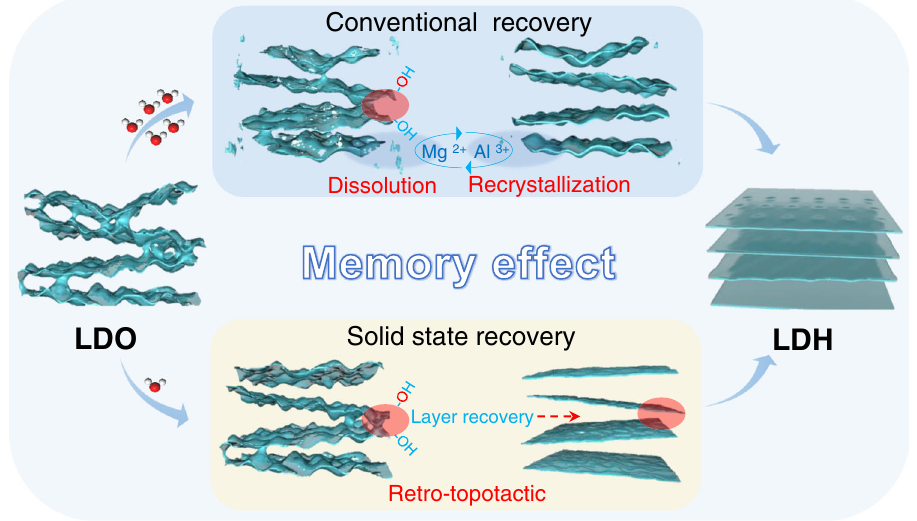
Fig. 8 | Schematic representation of memory effect mechanisms. The above route from LDO to LDH represents conventional recovery with a large amount of water, in which dissolution occurs fi rst, followed by recrystallization of LDH